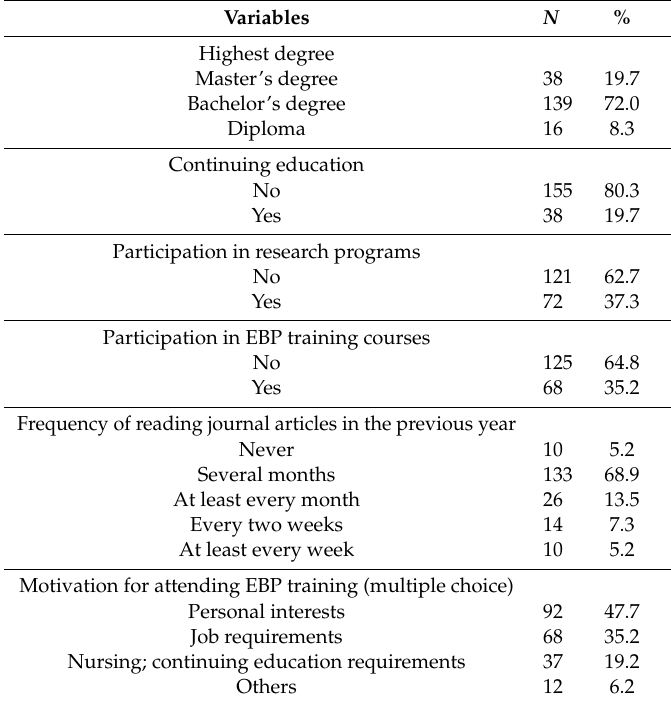
Table 2. Participant demographics ( N =